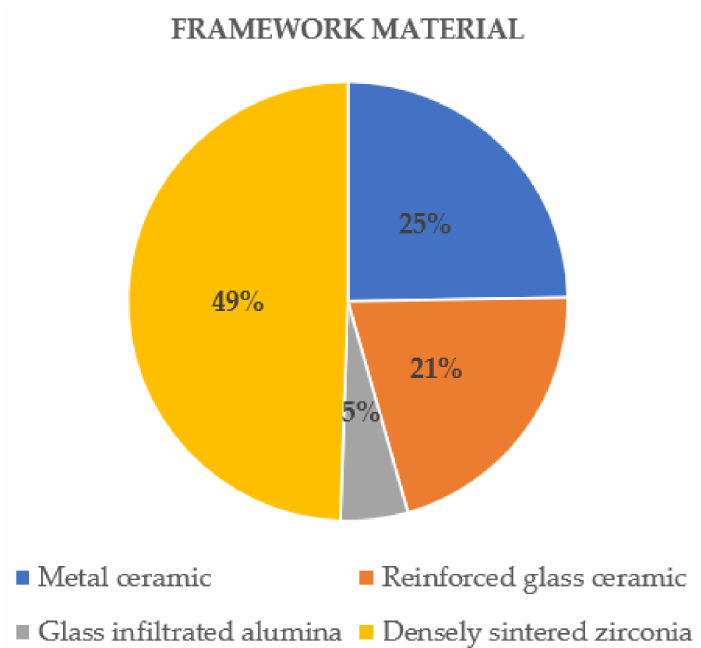
Figure 4. Distribution of the evaluated framework